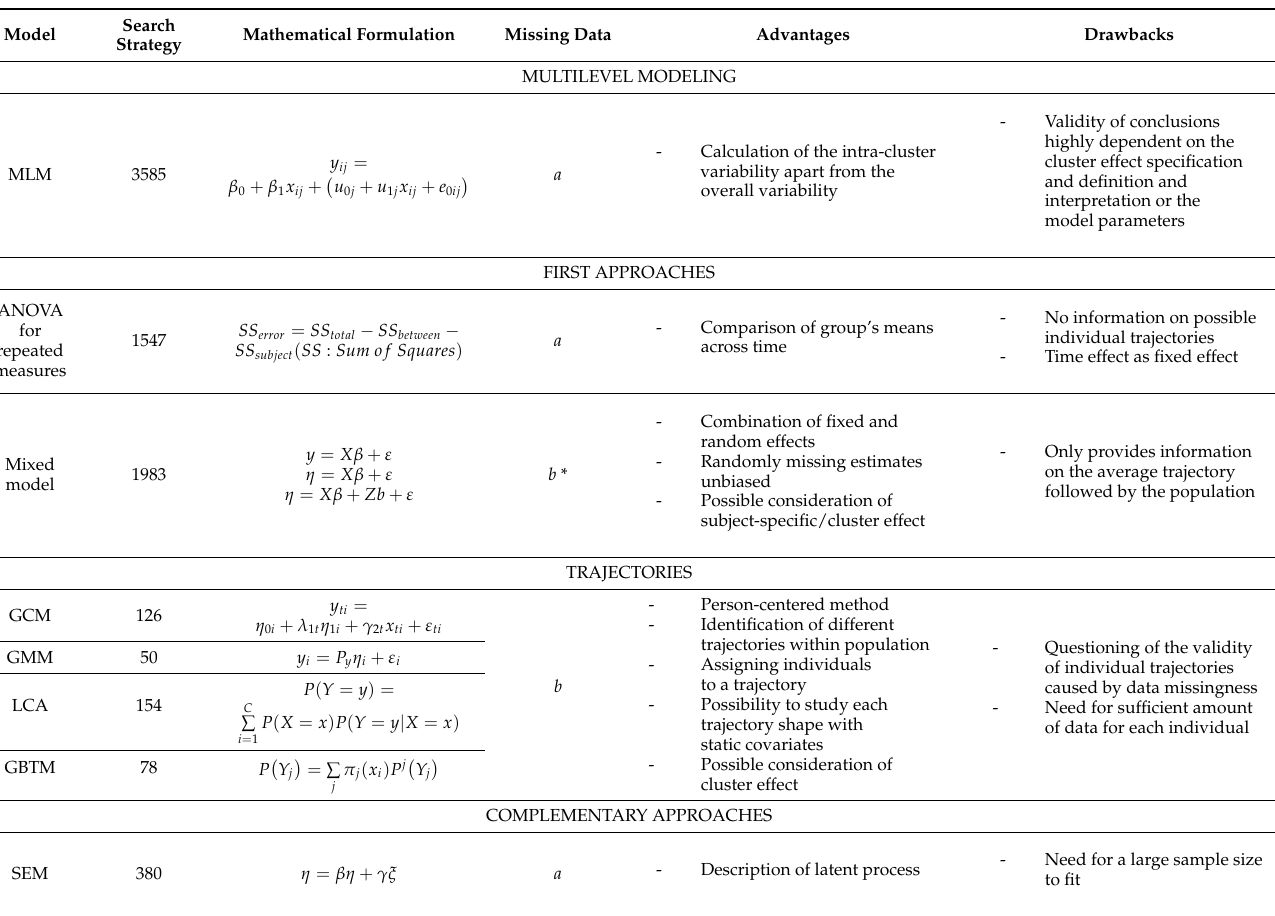
Table A1. Summary of the different